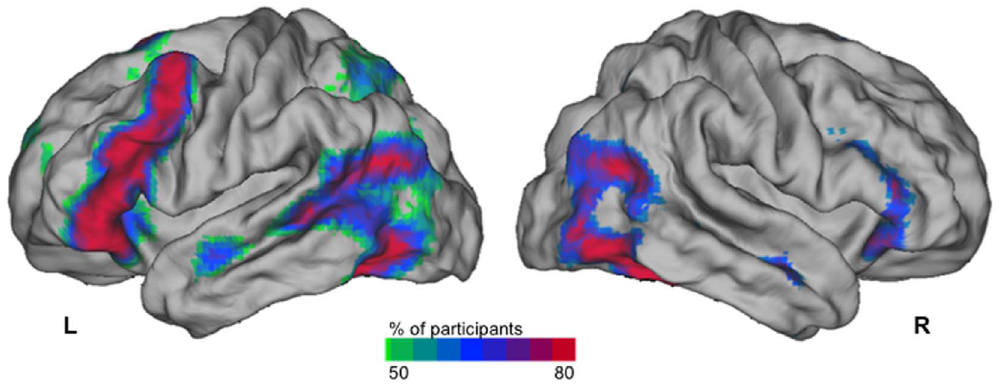
Figure 3. Probability map of the right-handed participants having a significant activation during sentence generation (SENT) as compared to recitation of a list of overlearned words (LIST) in the subgroup of 144 right-handers. 3D renderings of the probabilistic map of the individual SENT minus LIST contrast t-map after applying a t-threshold set at 1.96 (p , 0.05, uncorrected) superimposed on the Caret anatomical template. L: left, R: right. The scale starts with 50% of overlap and the red areas correspond to a proportion larger than 80% of right- handers showing a significant activation.